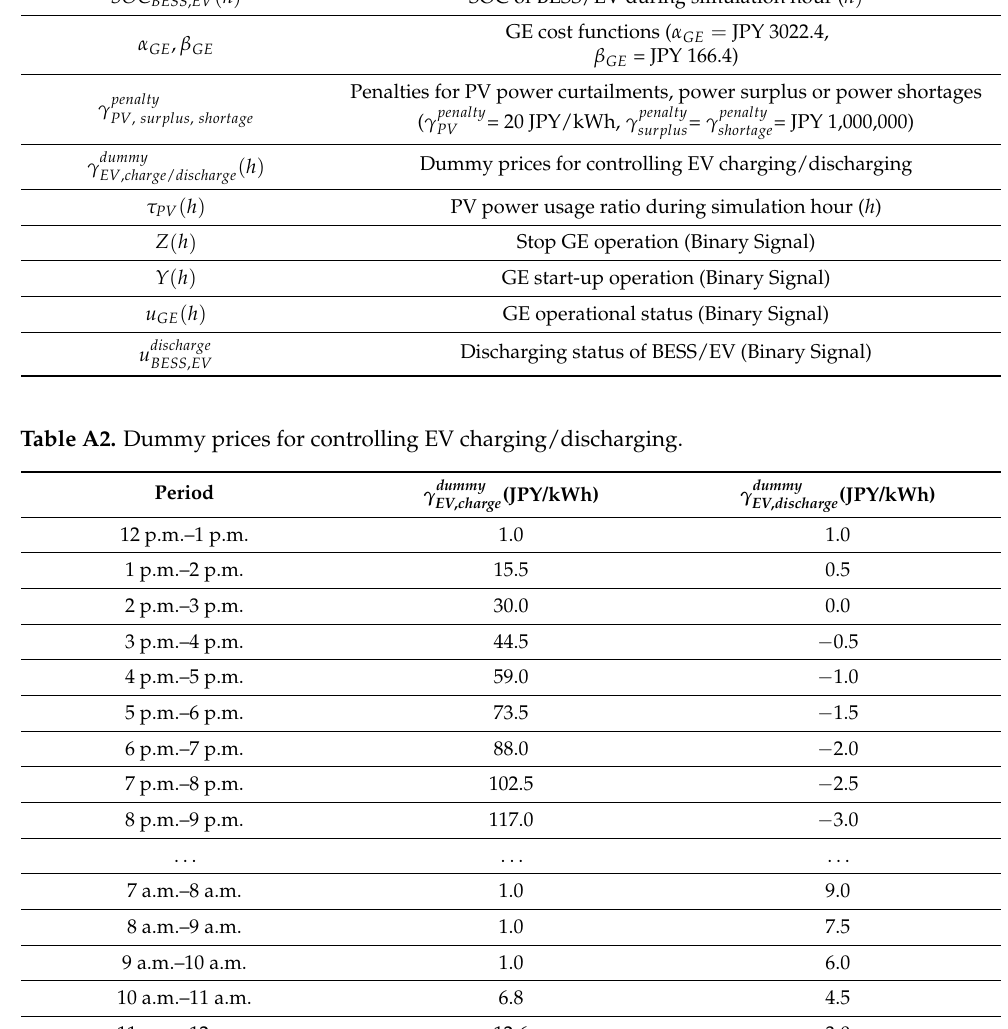
GE operational status (Binary Signal)